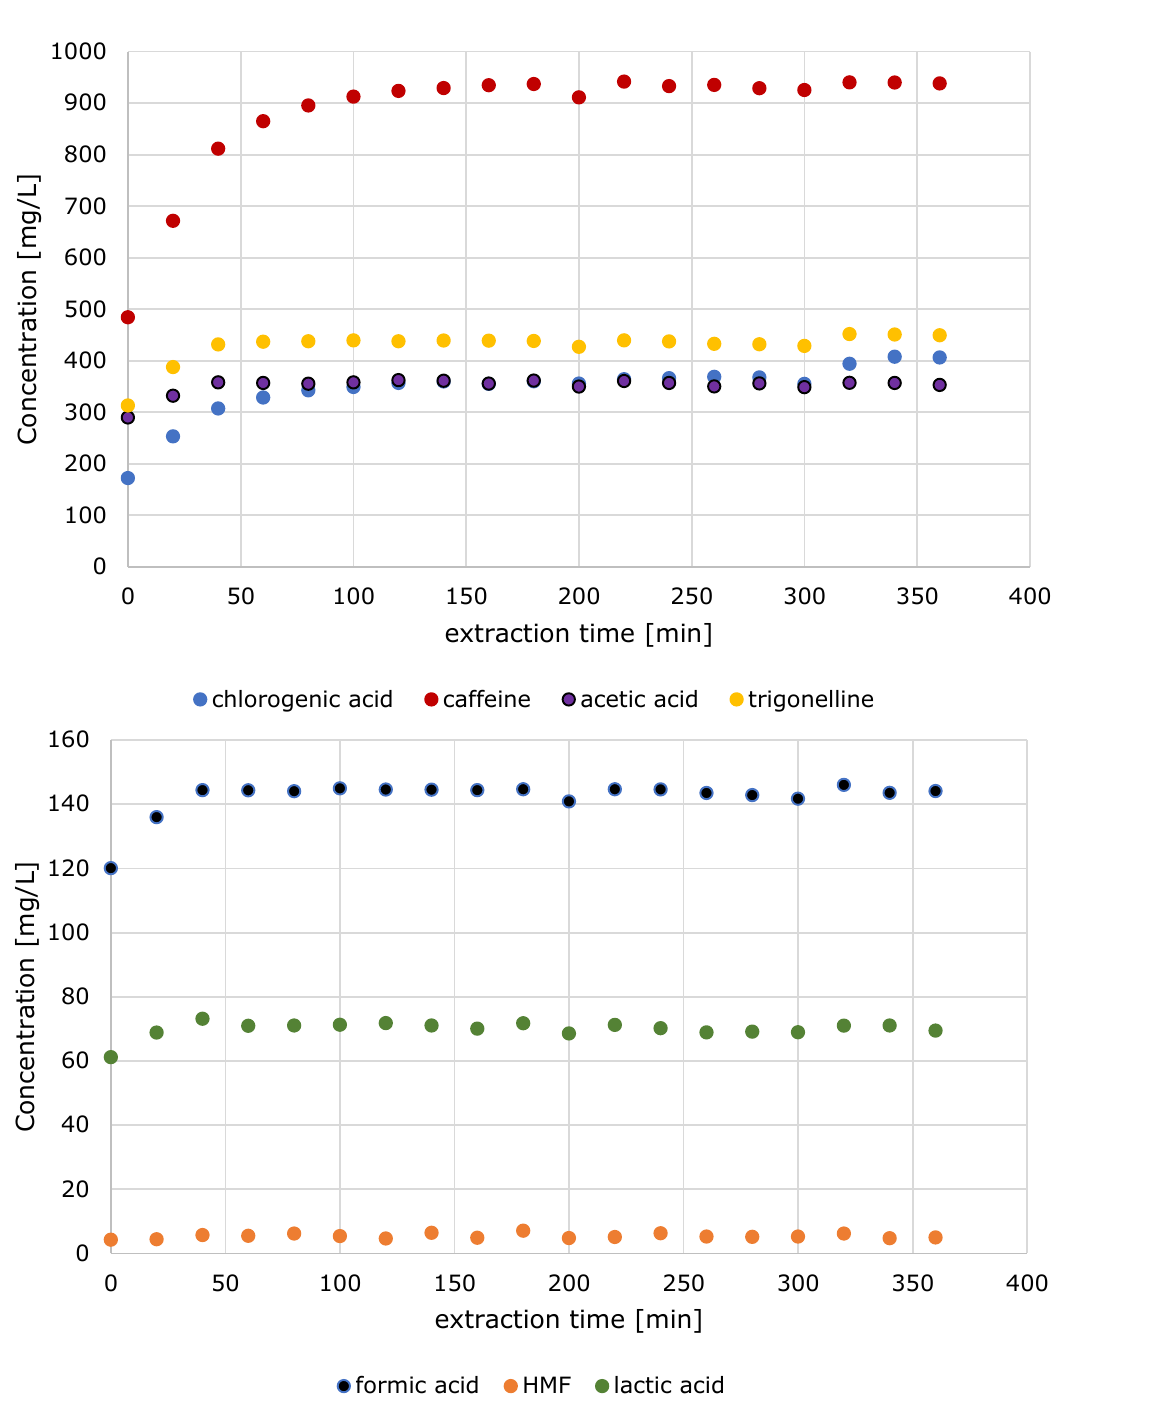
Figure 7. Evolution of chlorogenic acid, caffeine, acetic acid, trigonelline ( a ) and formic acid, 5-hydroxymethylfurfural (HMF), lactic acid ( b ) ( n = 1).